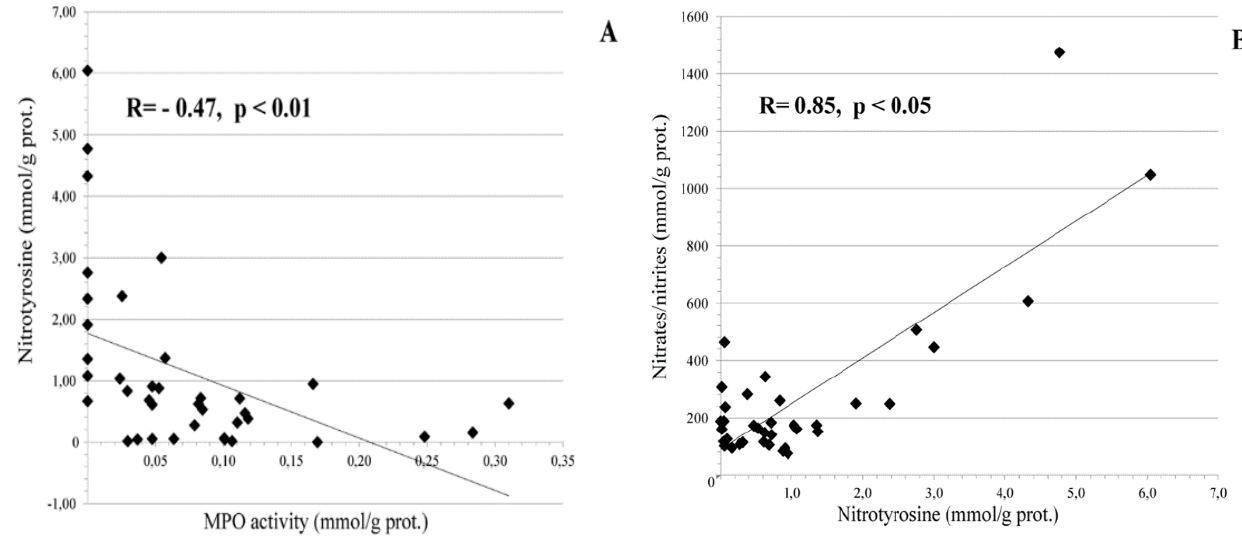
Figure 2. Correlations between redox parameters in cervical tissue of HPV-infected females with CIN I and CIN II (n = 75). ( A ) Correlation between MPO activity and nitrotyrosine content; ( B ) correlation between nitrotyrosine and nitrate/nitrite levels.